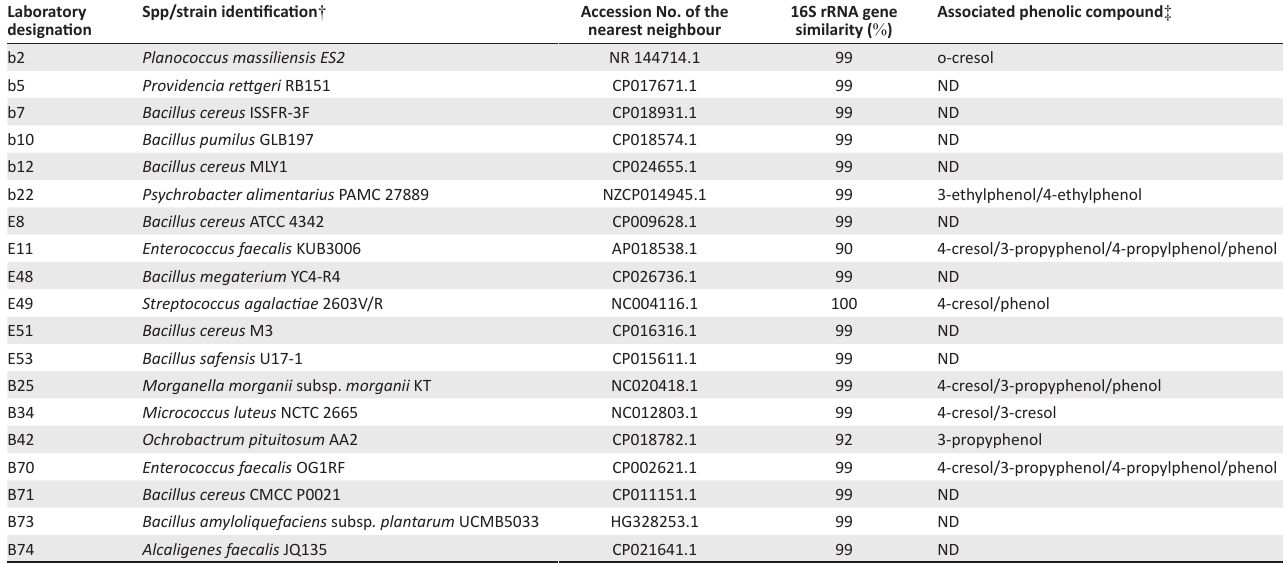
TABLE 2: Bacterial strains showing significant similarity with mammalian urine bacterial isolates tested for their ability to mediate production of